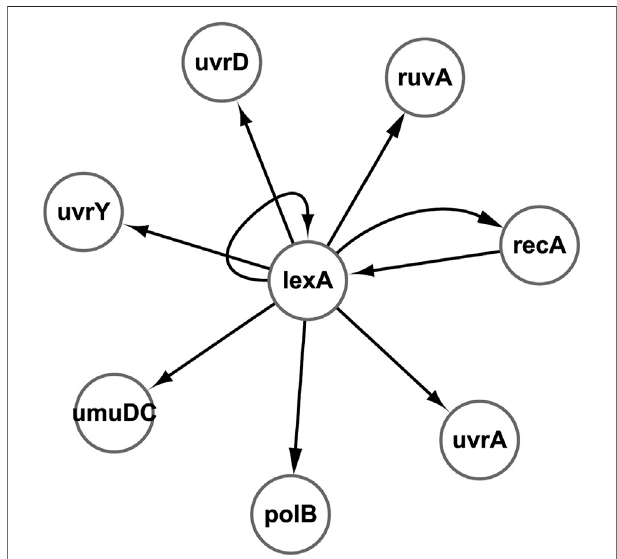
FIGURE 5 | SOS DNA repair network of E. coli .